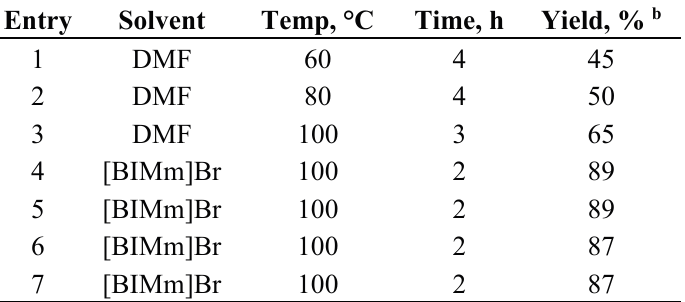
Table 1. Solvent-screen for the synthesis of heterocyclic hybrid 6h .